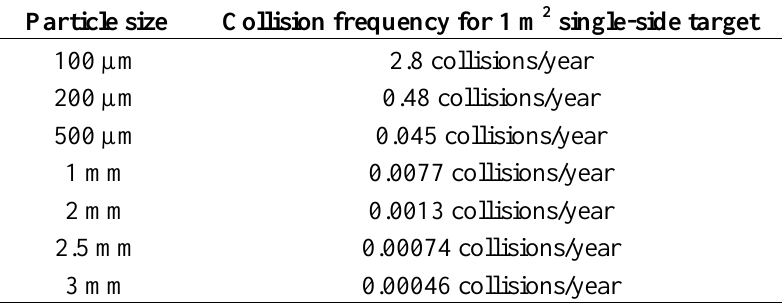
Table 1. Collision frequencies for various debris